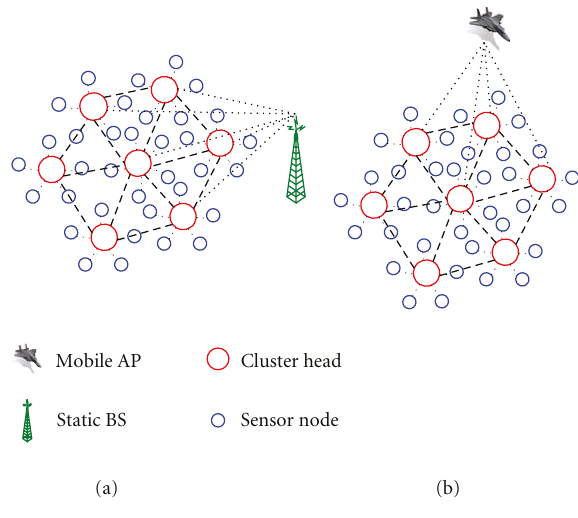
Figure 1: A three-tier hierarchical